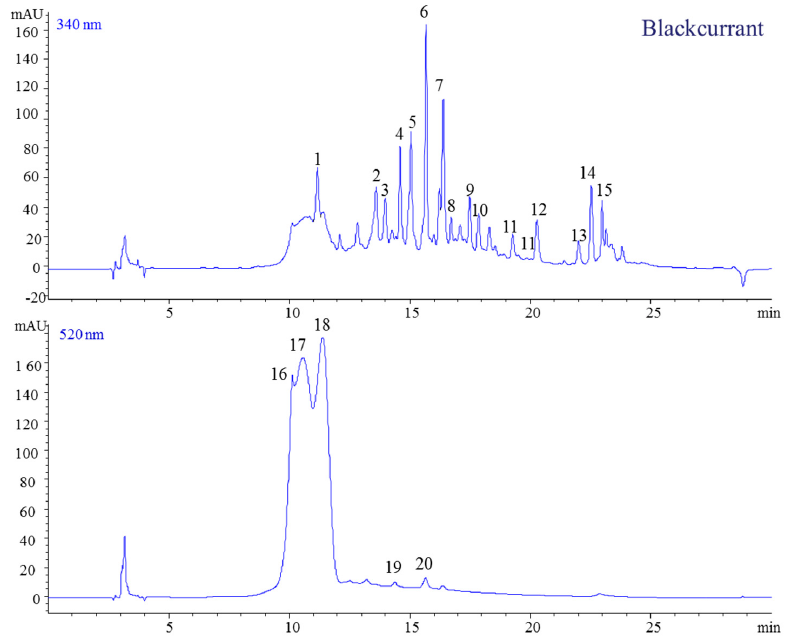
Figure 10. Chromatographic profile of berry extracts from blackcurrant jams (340 and 520 nm).